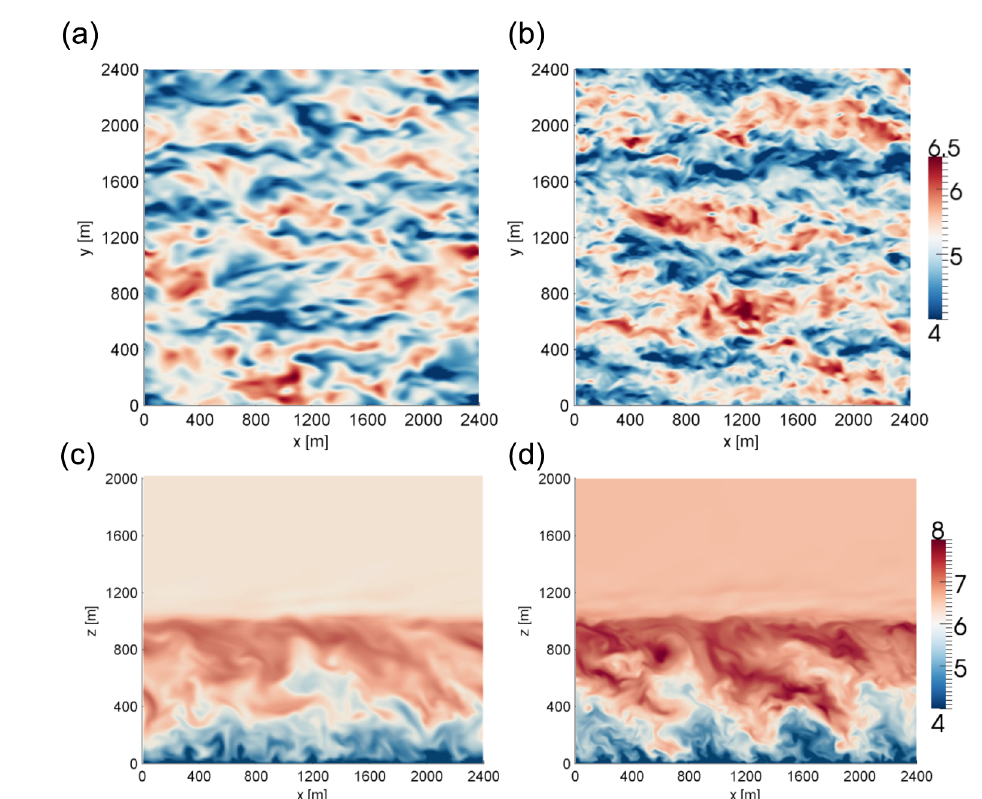
Figure 2. Comparisons of instantaneous horizontal wind speed [ms − 1 ] from the neutral case study, at 100m above the surface (a, b) and in a cross-stream plane midway through the domain (c, d) . From the HiGrad solver operating at a 15m resolution in each direction and using order 3 advective discretization (a, c) , and a 7.5m resolution in each direction and order 5 advective discretization (b, d) .